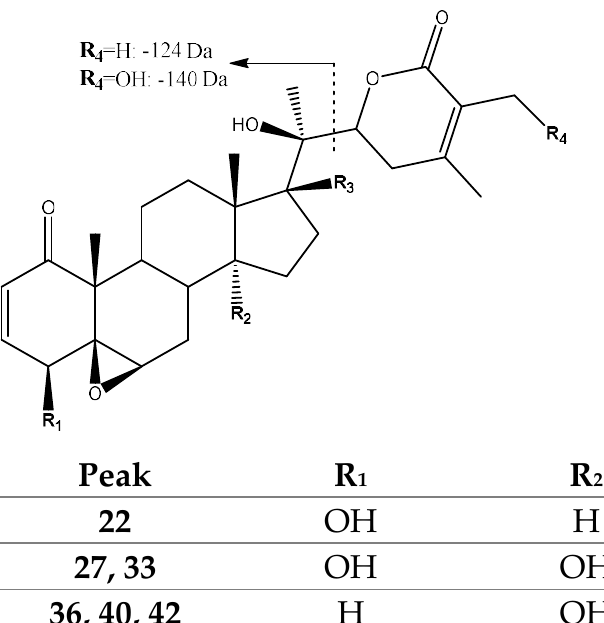
Figure 3. Fragmentation ion (MS 2 ) spectra for ( a ) compound 13, [M-H] − = 519.2601, with enlargement of range m / z 335–370, and ( b ) compound 27, [M-H] − = 501.2494.